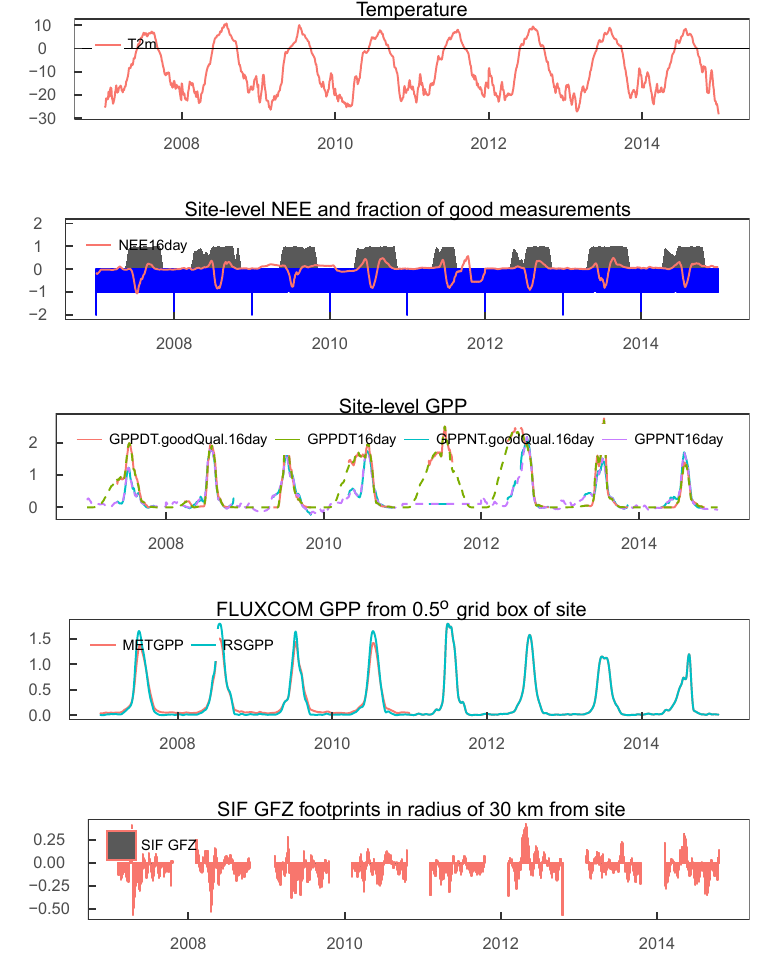
Figure A12. DK-ZaH: Time series (16 day averages) of quality filtered air temperature and NEE; blue bars indicate fraction of available good quality temperature data and gray bars indicate fraction of good and gap-filled NEE data. The middle panel depicts the GPP derived from the night-time and daytime partitioning of NEE measurements, filtered for 80% of good quality and gap-filled NEE along with unfiltered measurements. The modelled GPP is taken from the 0.5 ◦ grid cell with centre coordinates closest to the tower. The bottom panel displays the 16 day averages of SIF GFZ footprints within 30km of the